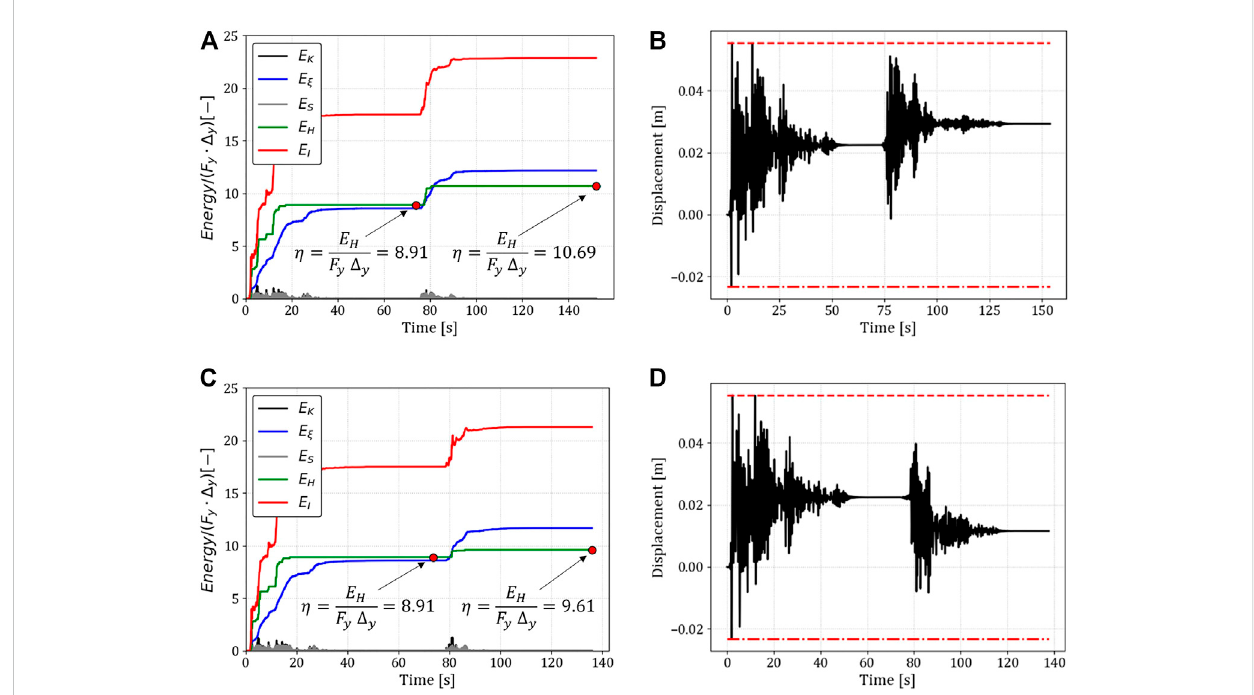
FIGURE 2 Example of non-linear dynamic behavior in terms of (A,C) hysteretic energy; and (B,D) displacement over time of an SDoF system subjected to two different ground motion